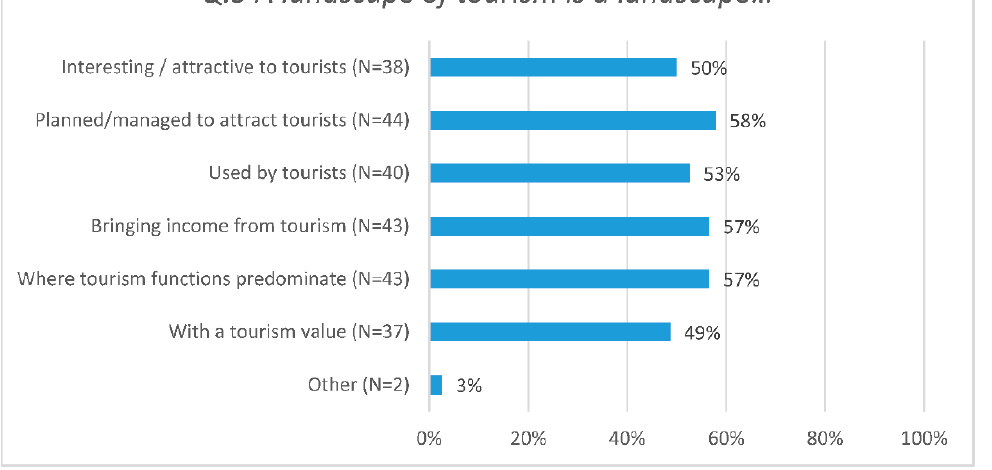
Figure 3. Perceptions on what a landscape of tourism is